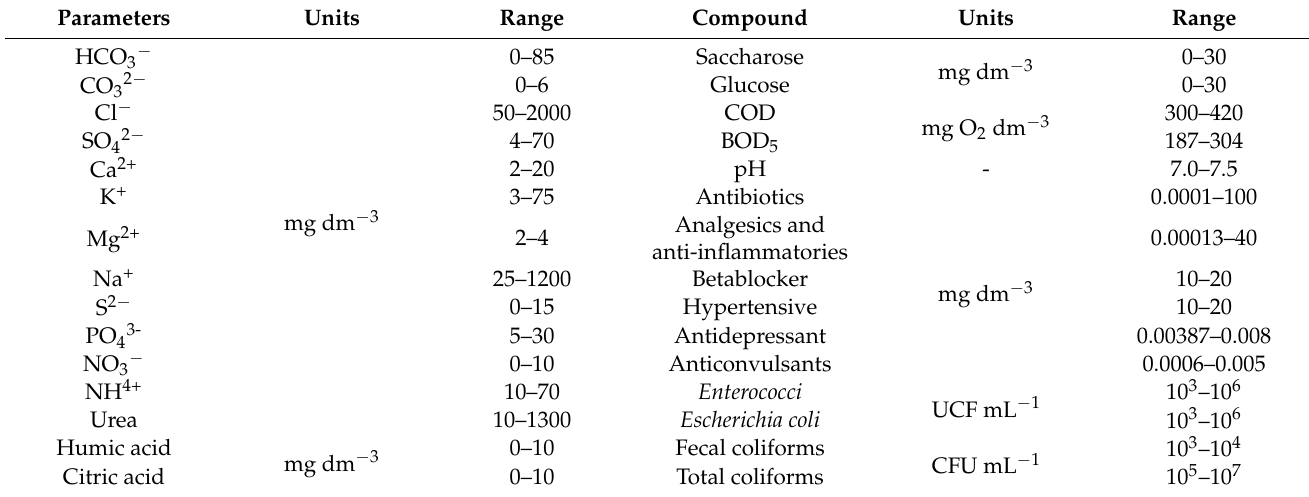
Table 1. Composition of